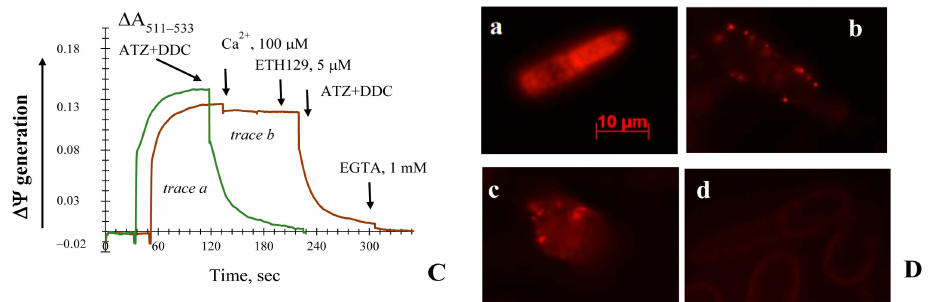
Figure 1. Effects of Ca 2+ , ATZ, and DDC on the ∆Ψ generated by the E. magnusii mitochondria respiring on a pyruvate + malate system. Additions and amounts are given in the figure by large arrows. Panel ( A ): Incubation medium contained 0.4 M mannitol, 0.1 M KCl, 20 mM Tris-acetate, 20 µ M safranin, pH 7.4, and 0.4 mg of mitochondria protein. Trace a—control; trace b shows the effect of the addition of 500 µ M Ca 2+ on the ∆Ψ if the ions are taken up; trace c—the effect of a combined action of 4 mM ATZ and 4 mM DDC on the membrane potential. Small arrows indicate stirring for aeration. Panel ( B ): trace a shows 100 µ M Ca 2+ uptake. The medium was the same as that in Panel ( A ); instead of 20 µ M safranin, 50 µ M murexide was added; trace b shows 100 µ M Ca 2+ uptake in the same medium as that in trace a. The red arrow indicates the Ca 2+ addition. Panel ( C ) incubation medium was the same as that in Panel ( A ). Trace a shows the effect of the addition of 4 mM DDC and 4 mM ATZ; trace b shows the effect of the addition of 100 µ M Ca 2+ followed by a combined action of 5 µ M ETH129, 4 mM DDC, and 4 mM ATZ. Small arrows indicate the stirring for aeration. Panel ( D ): Micro-images of the potential-dependent stained’ mitochondria in the E. magnusii cells raised in the mid-exponential growth phase using Rh123. The regions of high mitochondrial polarization are bright red due to concentrated dye. a—control, magnification 100 × ; b, c—cells were pre-treated with both 4 mM ATZ and 4 mM DDC for 30 min, magnification 100 × ; c—the incubation medium contained 1 mM Ca 2+ ; d—incubation medium contained 2 mM KCN. To examine the Rh123-stained preparations, filters of 02 and 15 (Zeiss) were used (magnification × 100). The photos were taken using an AxioCamMR camera. Figure 1A has been published in